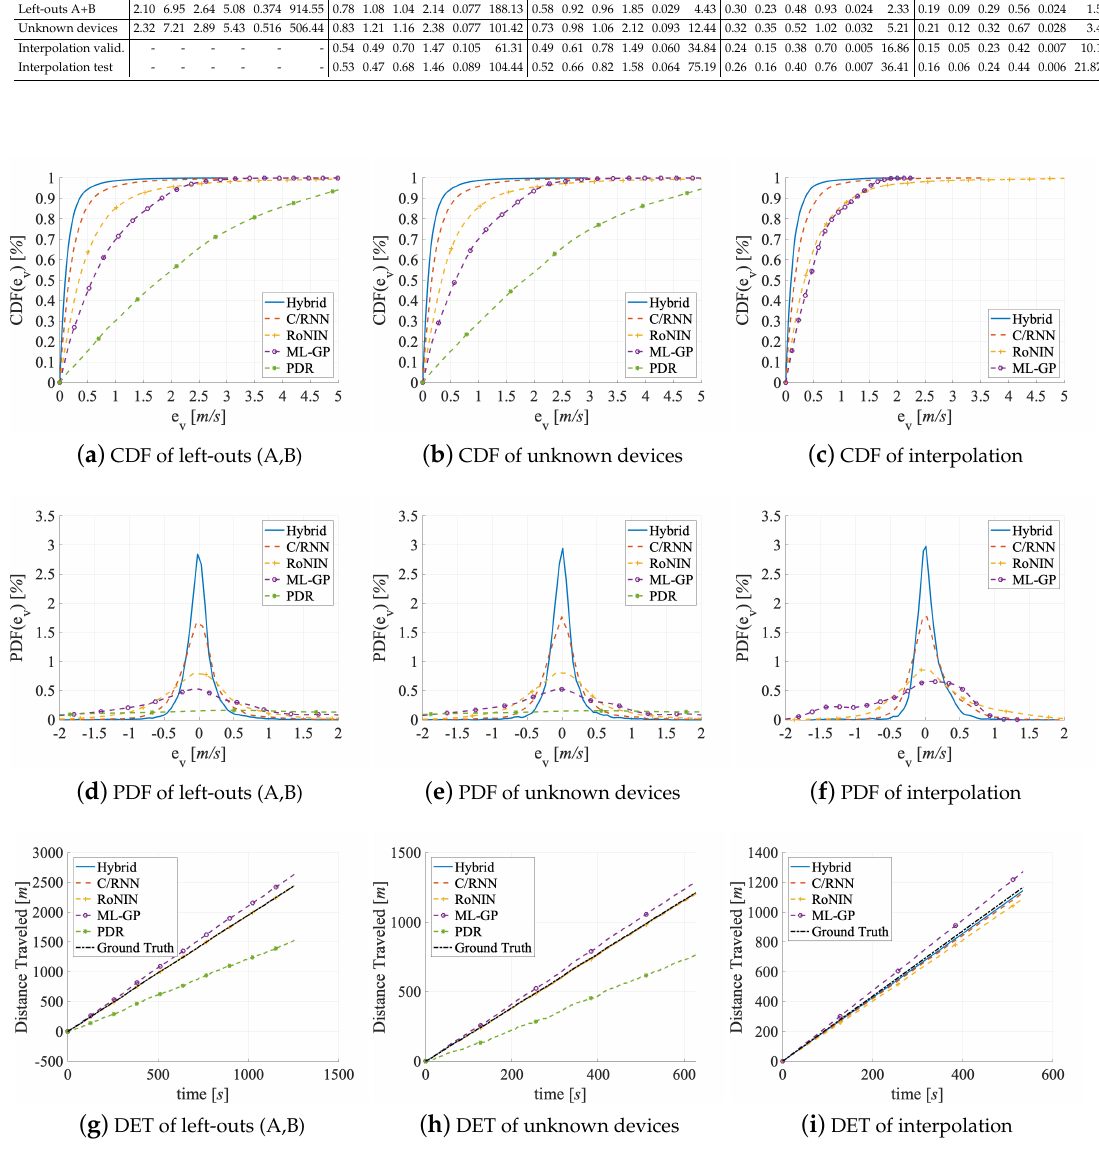
Figure 12. CDF, PDF, and DET of the generalizability benchmarks: left-outs (A,B), unknown devices, and the interpolation